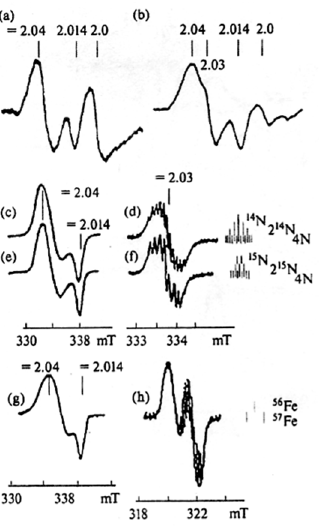
Figure 6. The 2.03 signals recorded in wet preparations of rabbit liver (curve ( a )) and yeasts (curve ( b )) and the EPR spectra of aqueous solutions of DNIC with cysteine containing 14 NO (curves ( c , d )), 15 NO (curves ( e , f ) or 57 Fe (curves g , h ) The EPR signals were recorded at ambient temperature (curves ( a , b , d , f , h )) or at 77 K (curves ( c , e , g )). Right panel: identification of characteristic HFS of DNIC with cysteine